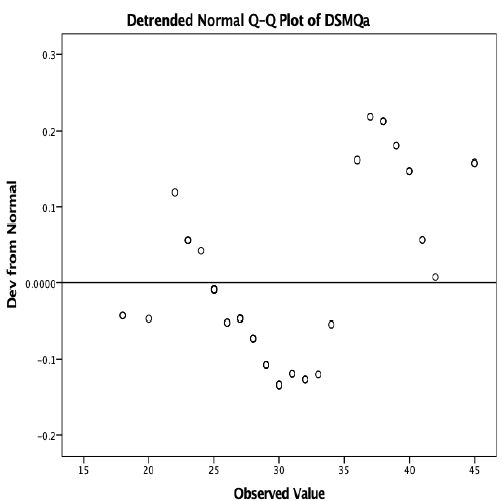
Figure 1. Distribution of the scores obtained in the DSMQ (DSMQa — initial evaluation).